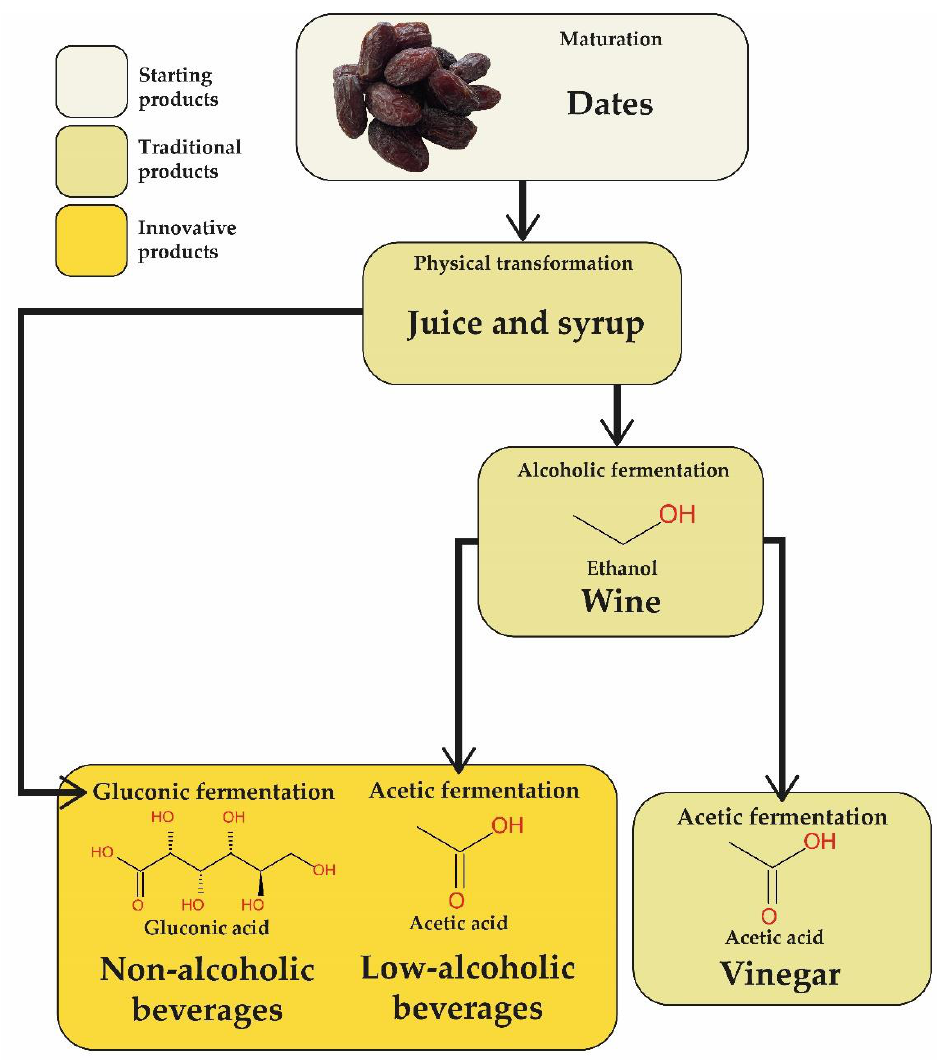
Figure 1. Traditional and innovative date fruit products. Box’s color indicates the type of products. Chemical compounds and their structure indicate the specific type of beverage.